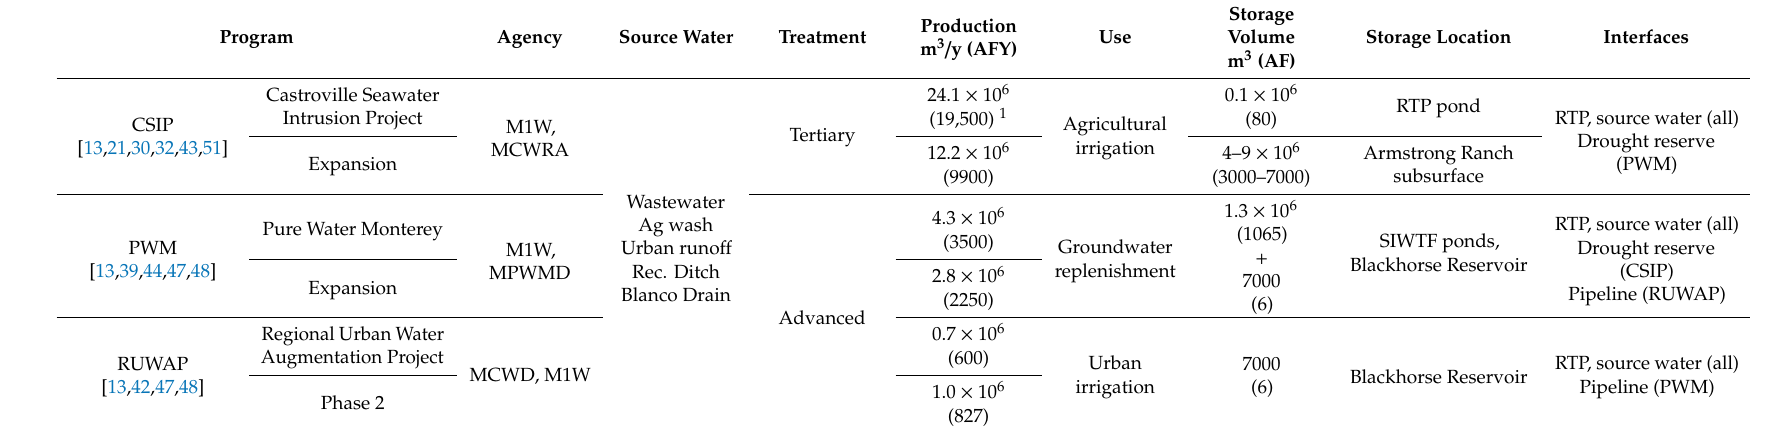
Table 2. Summary of reuse projects and proposed